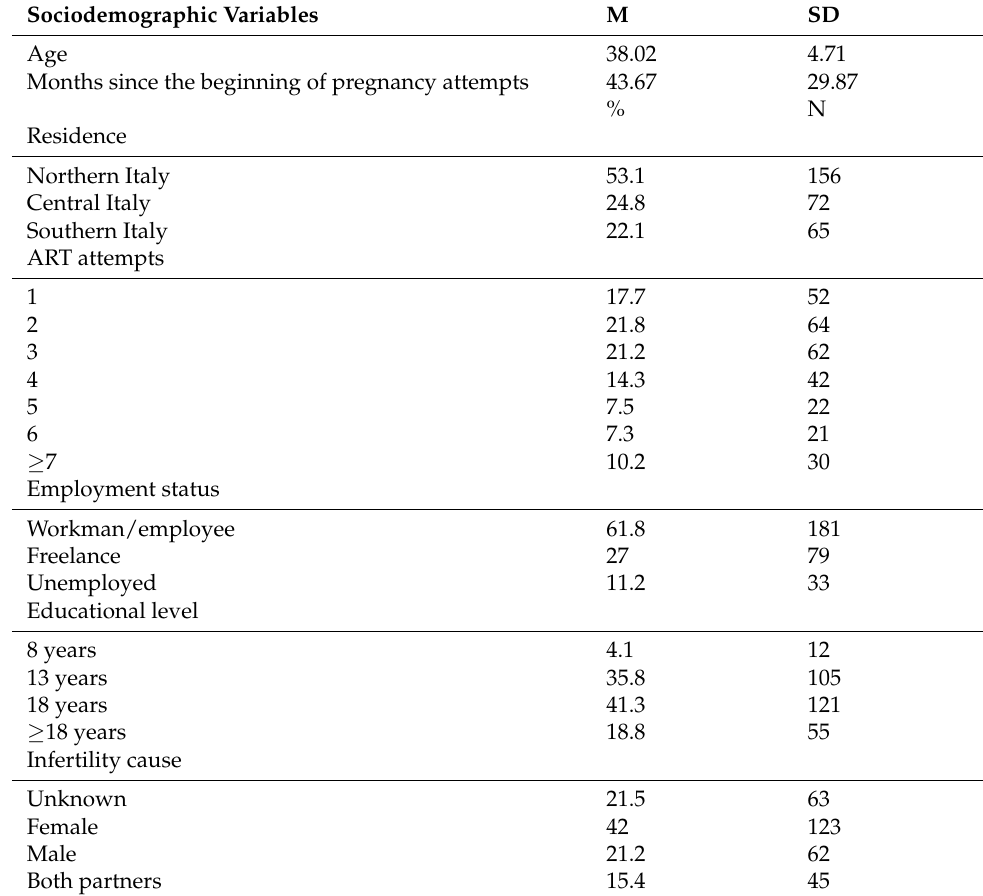
Table 1. Sociodemographic and Anamnestic Characteristics of the